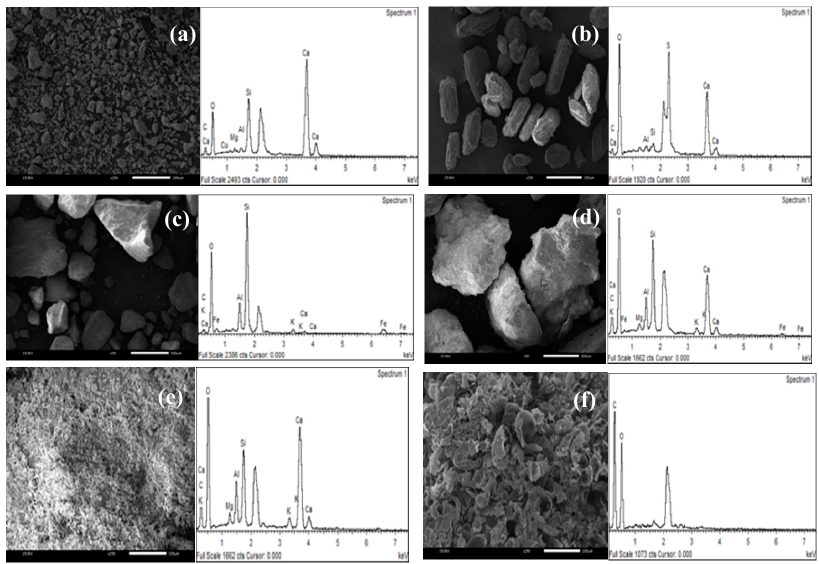
Figure 3. Microstructures of ( a ) OPC; ( b ) FGD gypsum; ( c ) coarse sand; ( d ) CDW; ( e ) gravel; and ( f )